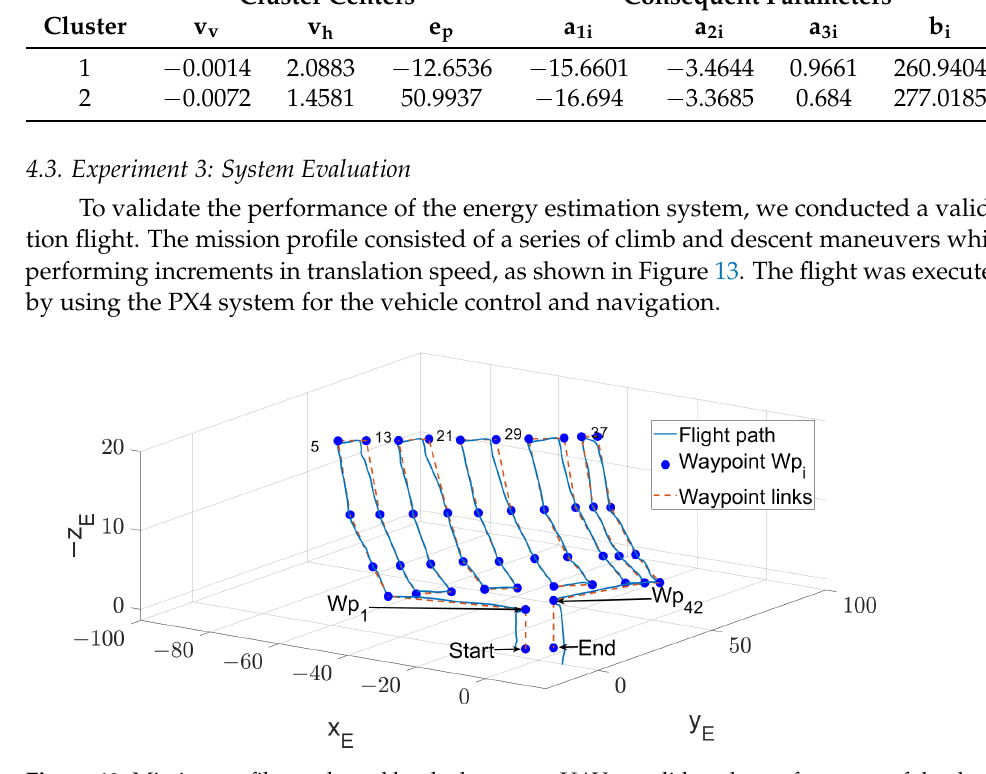
Figure 13. Mission profile conducted by the hexarotor UAV to validate the performance of the devel- oped energy estimation system. The blue dots represent the waypoints that defined the multirotor UAV mission during the flight. The dotted orange line is the trajectory linking 42 waypoints, and the solid blue line corresponds to the multirotor UAV